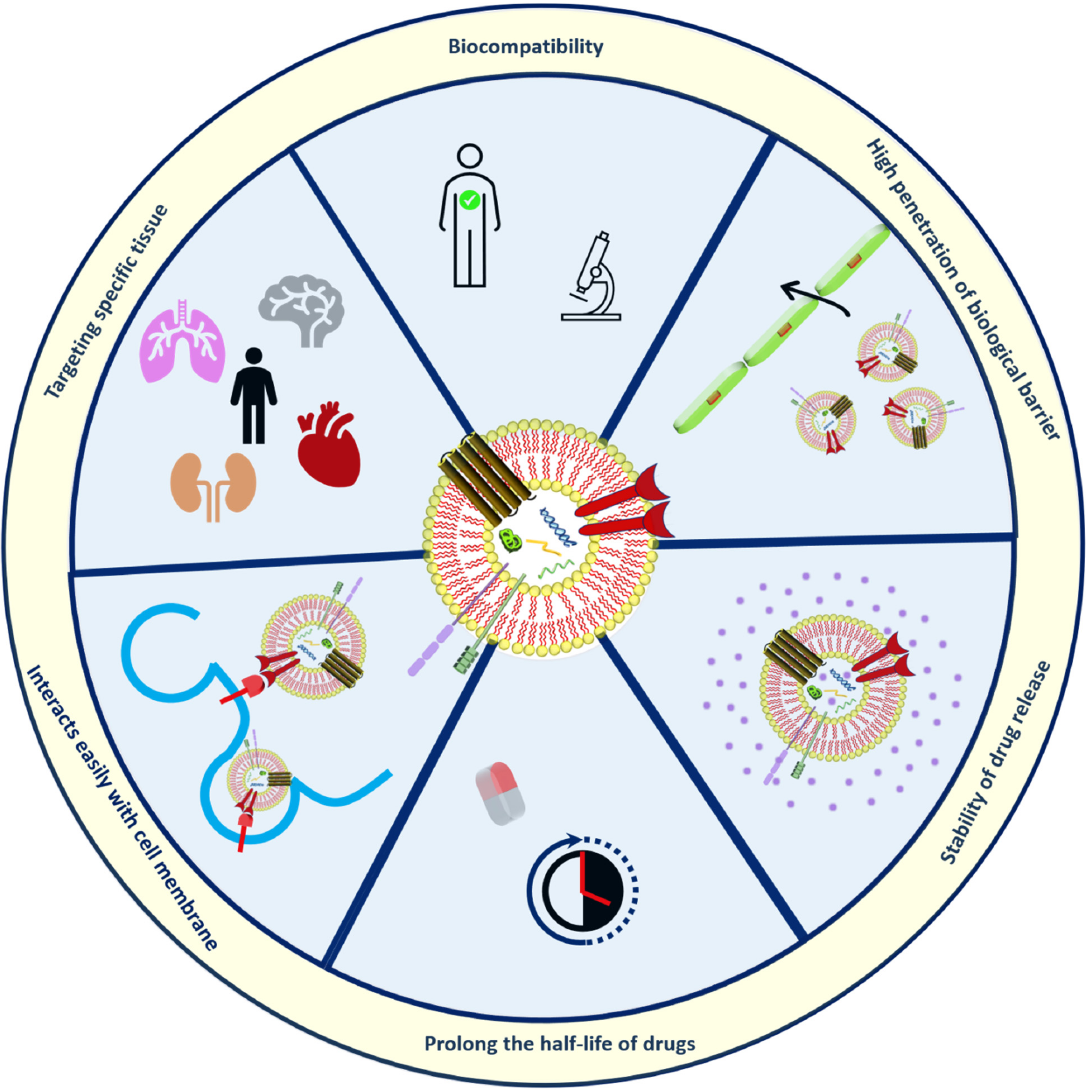
Figure 3. Structural organization and Merits of exosomes.